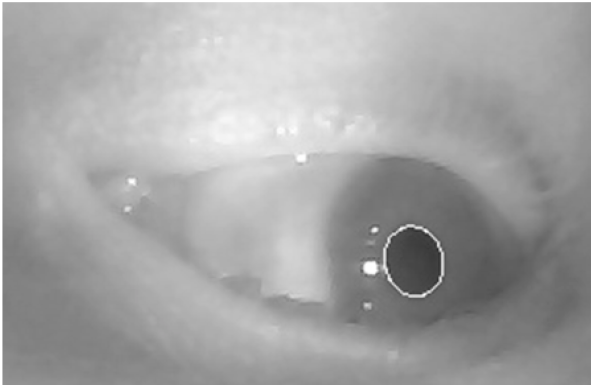
Figure 3. Eye and pupil detection (large white circle) shown in eye camera image.